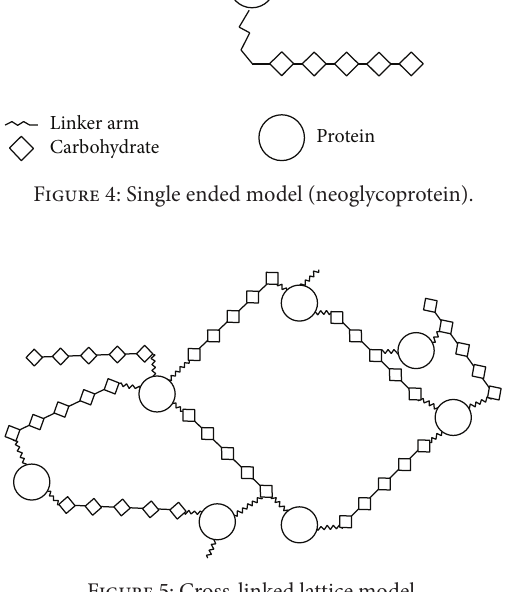
Figure 5: Cross-linked lattice